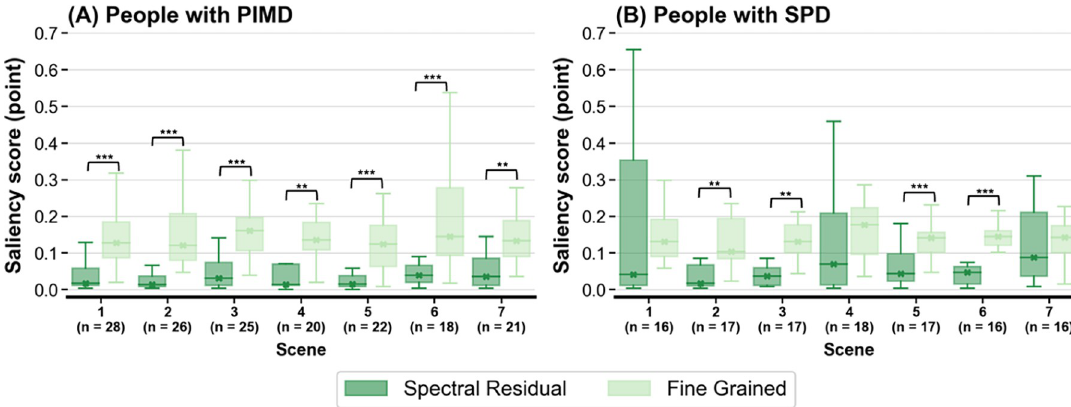
Fig 7. Distribution of saliency scores for each scene in PIMD and SPD groups. Distribution of spectral-residual and fine-grained scores for each scene are presented as box-and-whisker plots in (A) PIMD group and (B) SPD group. The fine-grained scores were significantly higher than the spectral-residual scores for all scenes for the PIMD group and four scenes (scenes 2, 3, 5, and 6) for the SPD group. Box-and-whisker plots show median values ( − ), average ( × ), interquartile ranges, minimum and maximum values, and outliers. � p < .05, �� p < .01, ��� p < .001. PIMD, profound intellectual and multiple disabilities; SPD, severe physical disabilities.